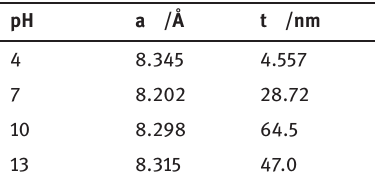
Table 2: Lattice parameter (a) and crystallite size (t) for spinel samples prepared at different pH. (Sample at pH=1.5 is excluded since it has no spinel